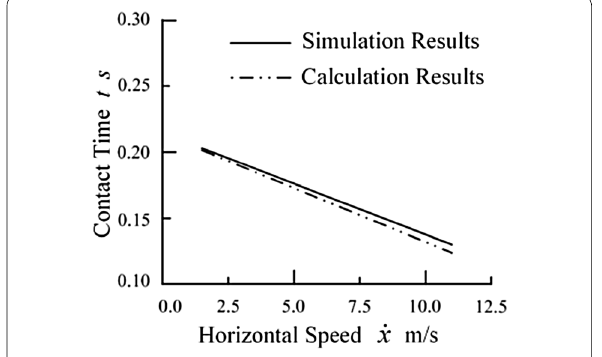
Figure 5 Calculation results of contact time